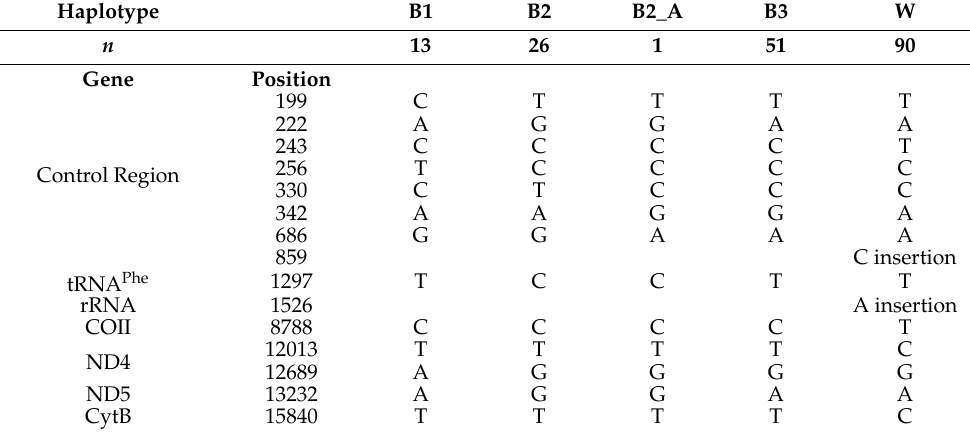
Table 2. Overview of the Single Nucleotide Polymorphism (SNPs) of the deduced four haplotypes with number of individuals ( n ), gene/region, position and corresponding nucleotide.